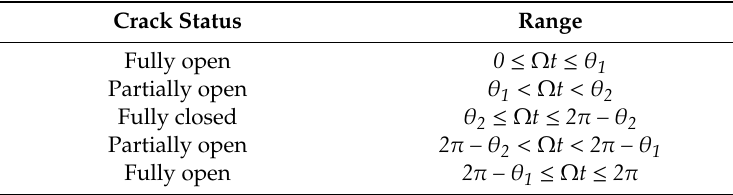
Table 2. Crack state based on the shaft rotation angle.